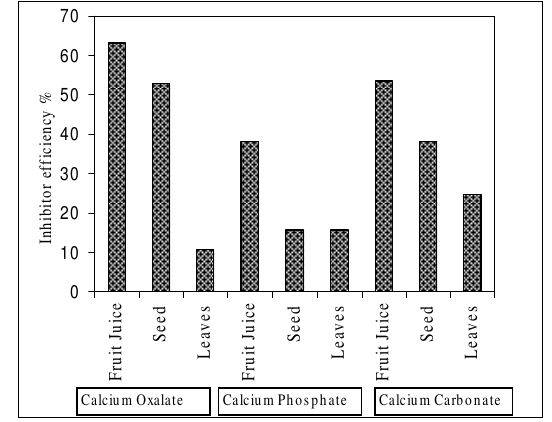
Figure 5 . Inhibition Efficiency of Aerva lanata (Linn.) ( P5 ). Table 2 .Average inhibition efficiency of all